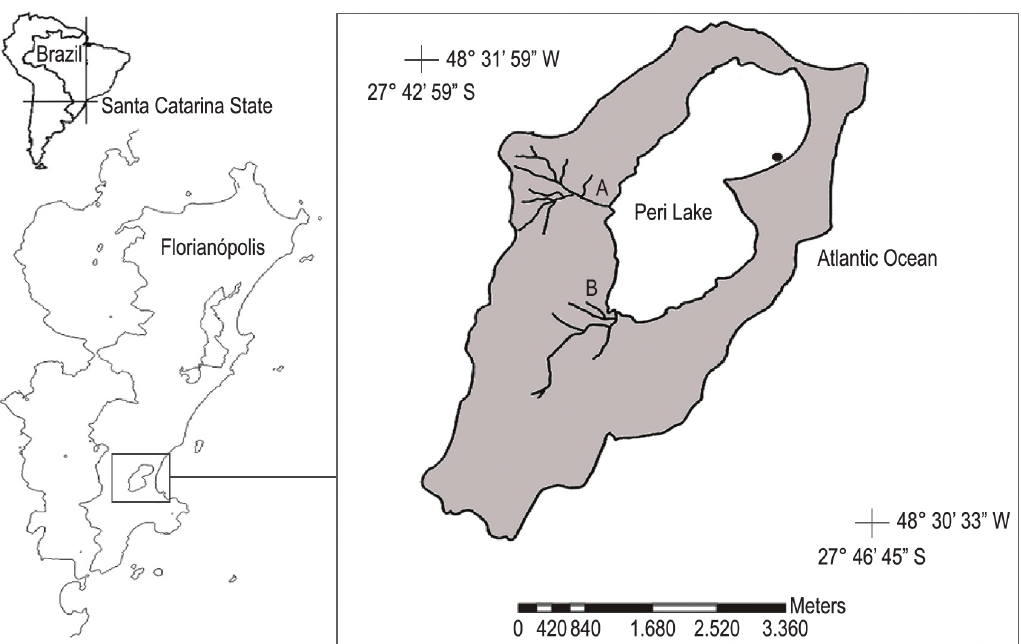
Figure 1. Location of the Peri Lake, in Santa Catarina Island, Brazil, showing the site sampled (littoral black dot). Letter A indicates Cachoeira Grande Stream and letter B indicates Ribeirão Grande Stream. Adapted from Hennemann and Petrucio